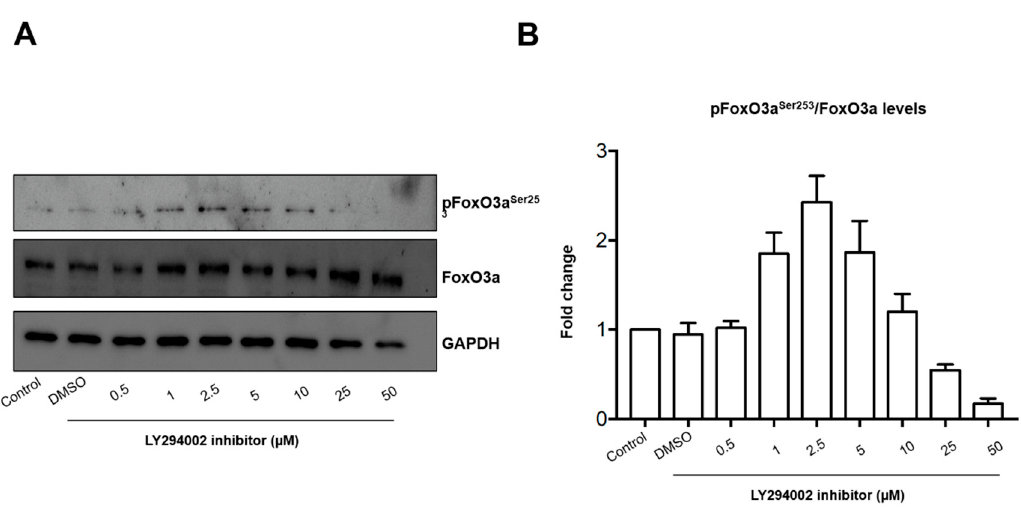
Figure 1. Dose-response curve of the LY294002 inhibitor over FoxO3a. The cells were incubated to a concentration of LY294002 inhibitor (0.0, 0.5, 1, 2, 5, 10, 25, 50 µM) for 24 h. Cells were cultured for 24 h in F12K medium supplemented with 10% of fetal bovine serum (FBS); Control: cells unexposed; DMSO: cells exposed only to DMSO (vehicle for LY294002). ( A ) Representative image of western blot of pFoxO3 Ser253 , FoxO3, and glyceraldehyde 3-phosphate dehydrogenase (GAPDH) as housekeeping control and ( B ) data from a duplicated assay.